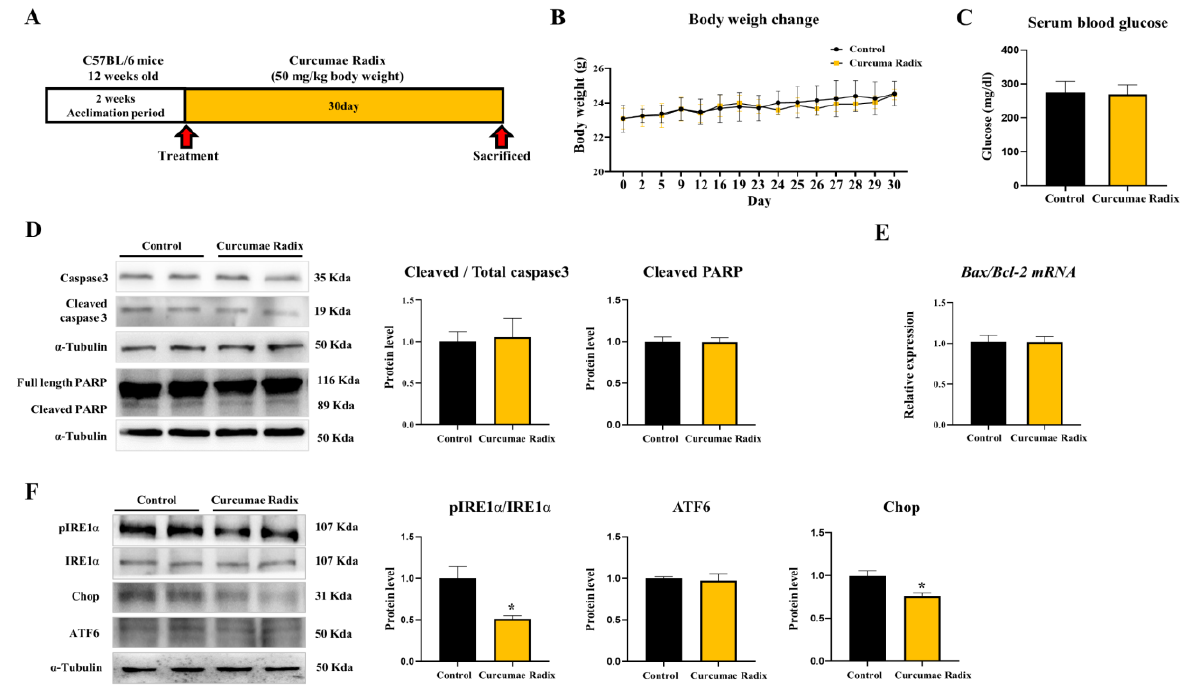
Figure 1. Curcumae radix decreases endoplasmic reticulum (ER) stress in mouse brain. ( A ) The Schematic diagram shows the schedule of the animal experiment. Twelve-week-old male mice had an acclimation period of 2 weeks. For 23 days five times a week, they were injected orally. For the last 7 consecutive days of administration, the CRE group was treated with Curcumae radix extract (CRE), and the vehicle group was treated with water (50 mg/kg body weight, n = 6). ( B ) Mouse body weight monitoring data. ( C ) Serum blood glucose level measured after sacrificed. ( D ) Western blot analysis and quantification of apoptosis-related genes were evaluated in the cerebrum of CRE male mice. Alpha-Tubulin was used as an internal control. ( E ) Bcl-2-associated X protein (Bax), B-cell lymphoma 2 (Bcl-2) genes mRNA levels were measured by quantitative RT-PCR and Bax, Bcl-2 genes mRNA levels were determined by the Bax/Bcl-2 ratio in the cerebrum of CRE treated male mice. RPLP0 was used as an internal control. ( F ) Western blot analysis and quantification of ER stress-related genes were evaluated in the cerebrum of CRE treated male mice. Alpha-Tubulin was used as an internal control. The values stand for means ± S.D. * p < 0.05 was compared to groups indicated. All experiments were repeated at least 3 times.